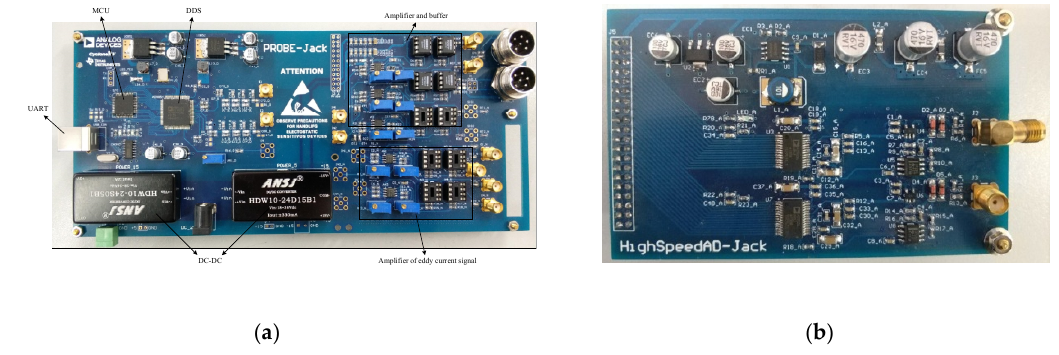
Figure 3. Electronic circuits of the experimental setup. ( a ) Drive circuit of the probe. ( b ) High-speed data acquisition circuit. MCU: Microcontroller Unit; DC-DC: Direct Current converter. Table 1. Features of the test specimens.